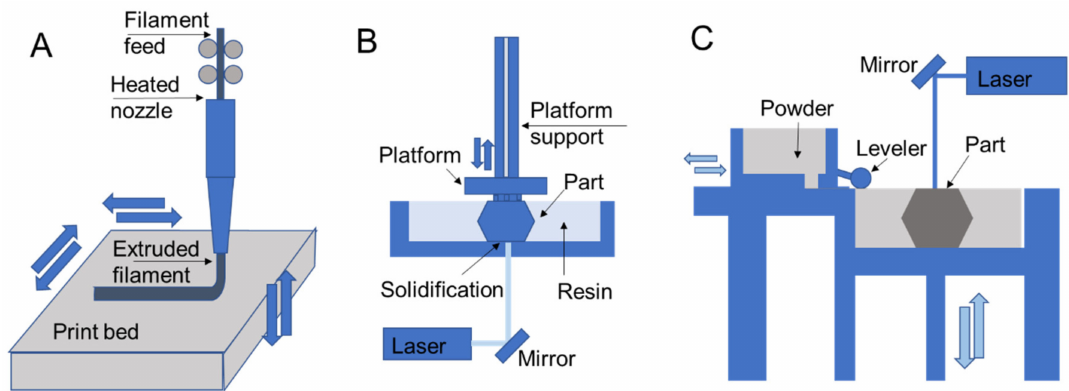
Figure 3. 3D printing schematics for ( A ) fused deposition modeling, ( B ) stereolithography, and ( C ) selective laser sintering that are representative of extrusion, resin, and powder processes,